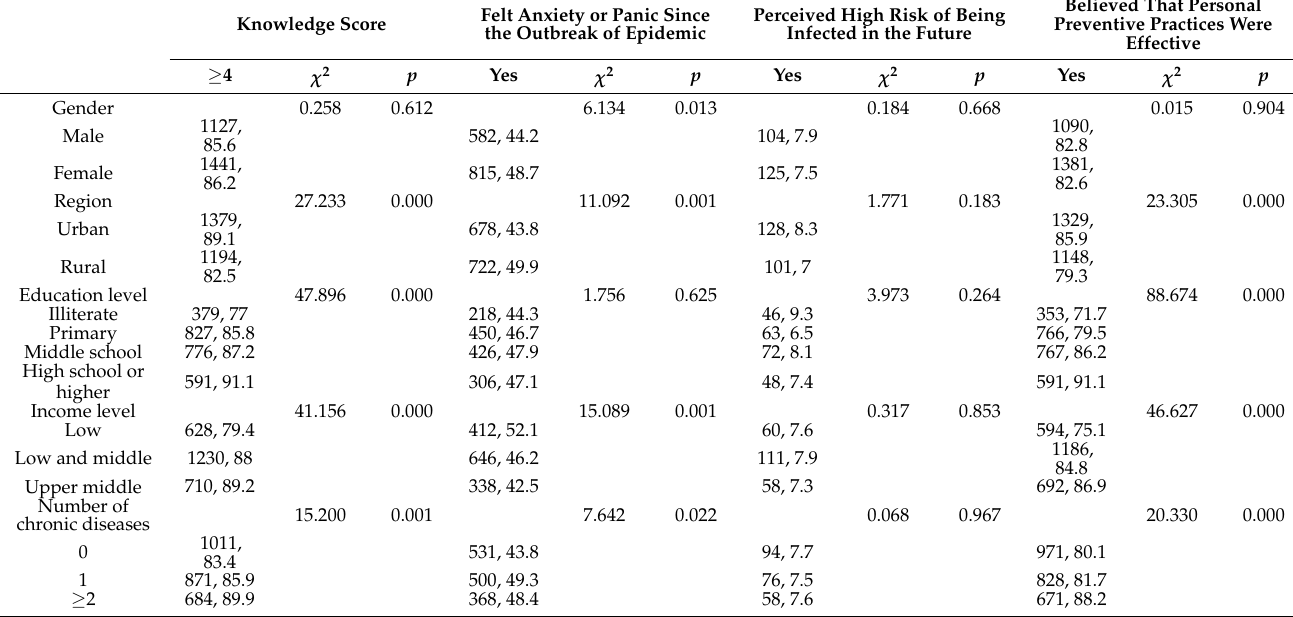
Table 2. Knowledge, anxiety, perceived vulnerability and response efficacy toward COVID-19 among older adults in different groups